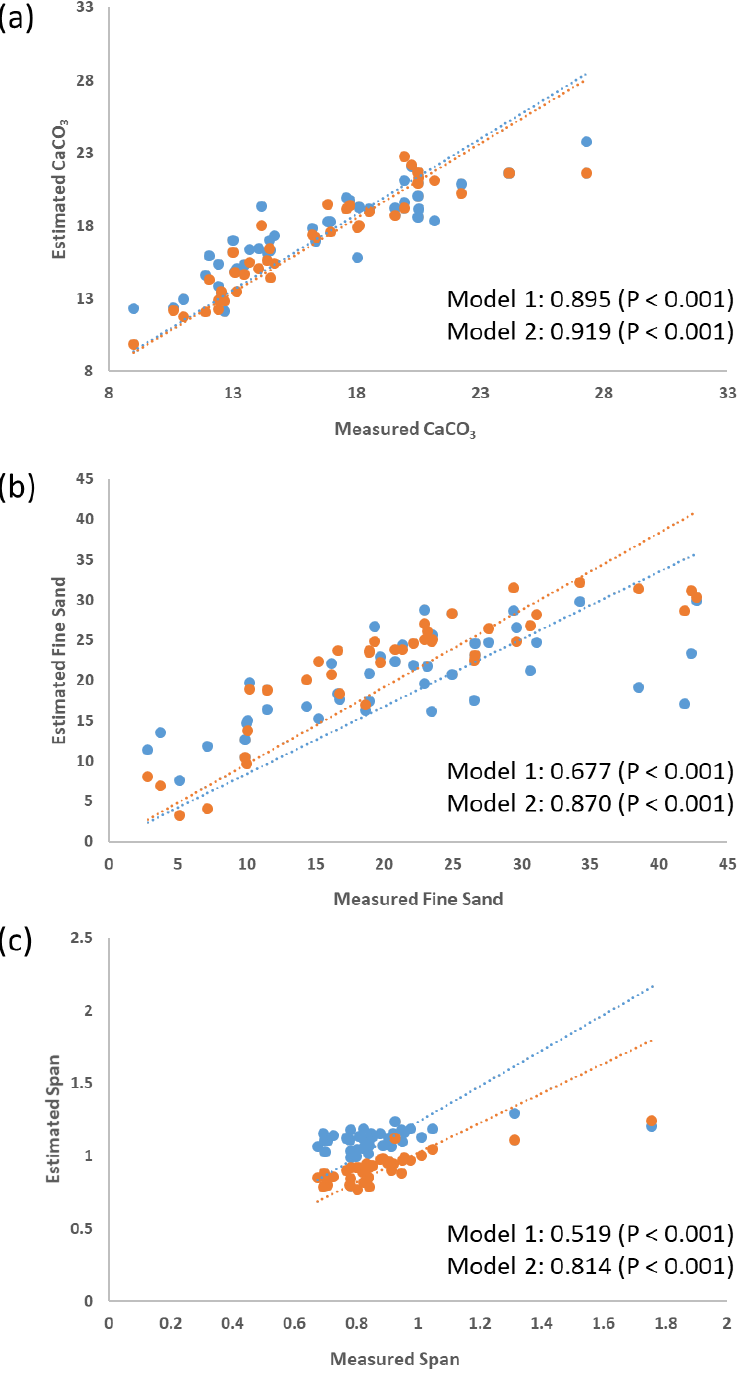
Figure 7. Relationship between estimated and measured ( a ) CaCO 3 , ( b ) fine sand %, and ( c ) span using a linear single wavelength model (model 1) and multilinear model (model 2).